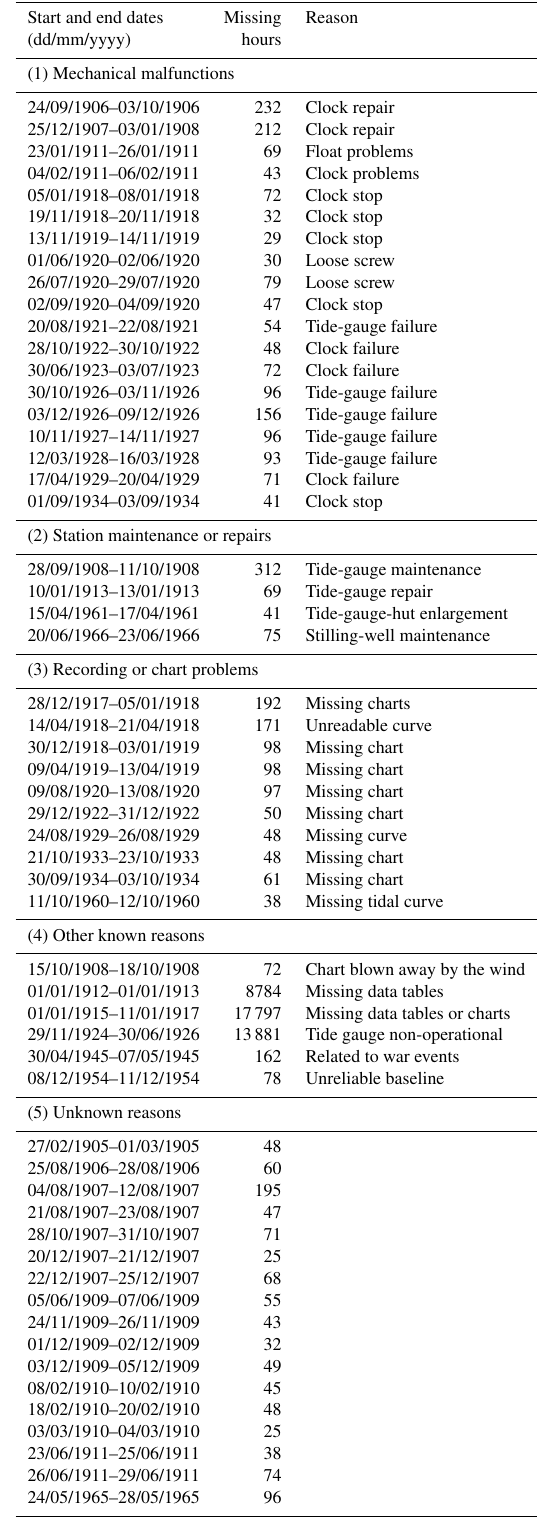
Table B1. List of the gaps in the hourly time